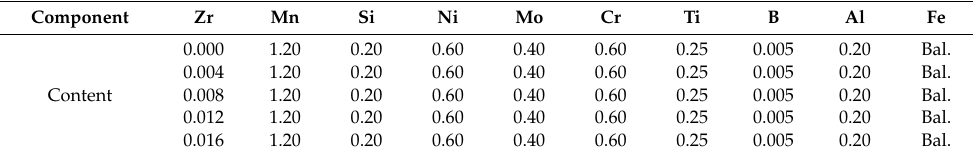
Table 4. Powder formula of flux cored wire (mass, wt %).